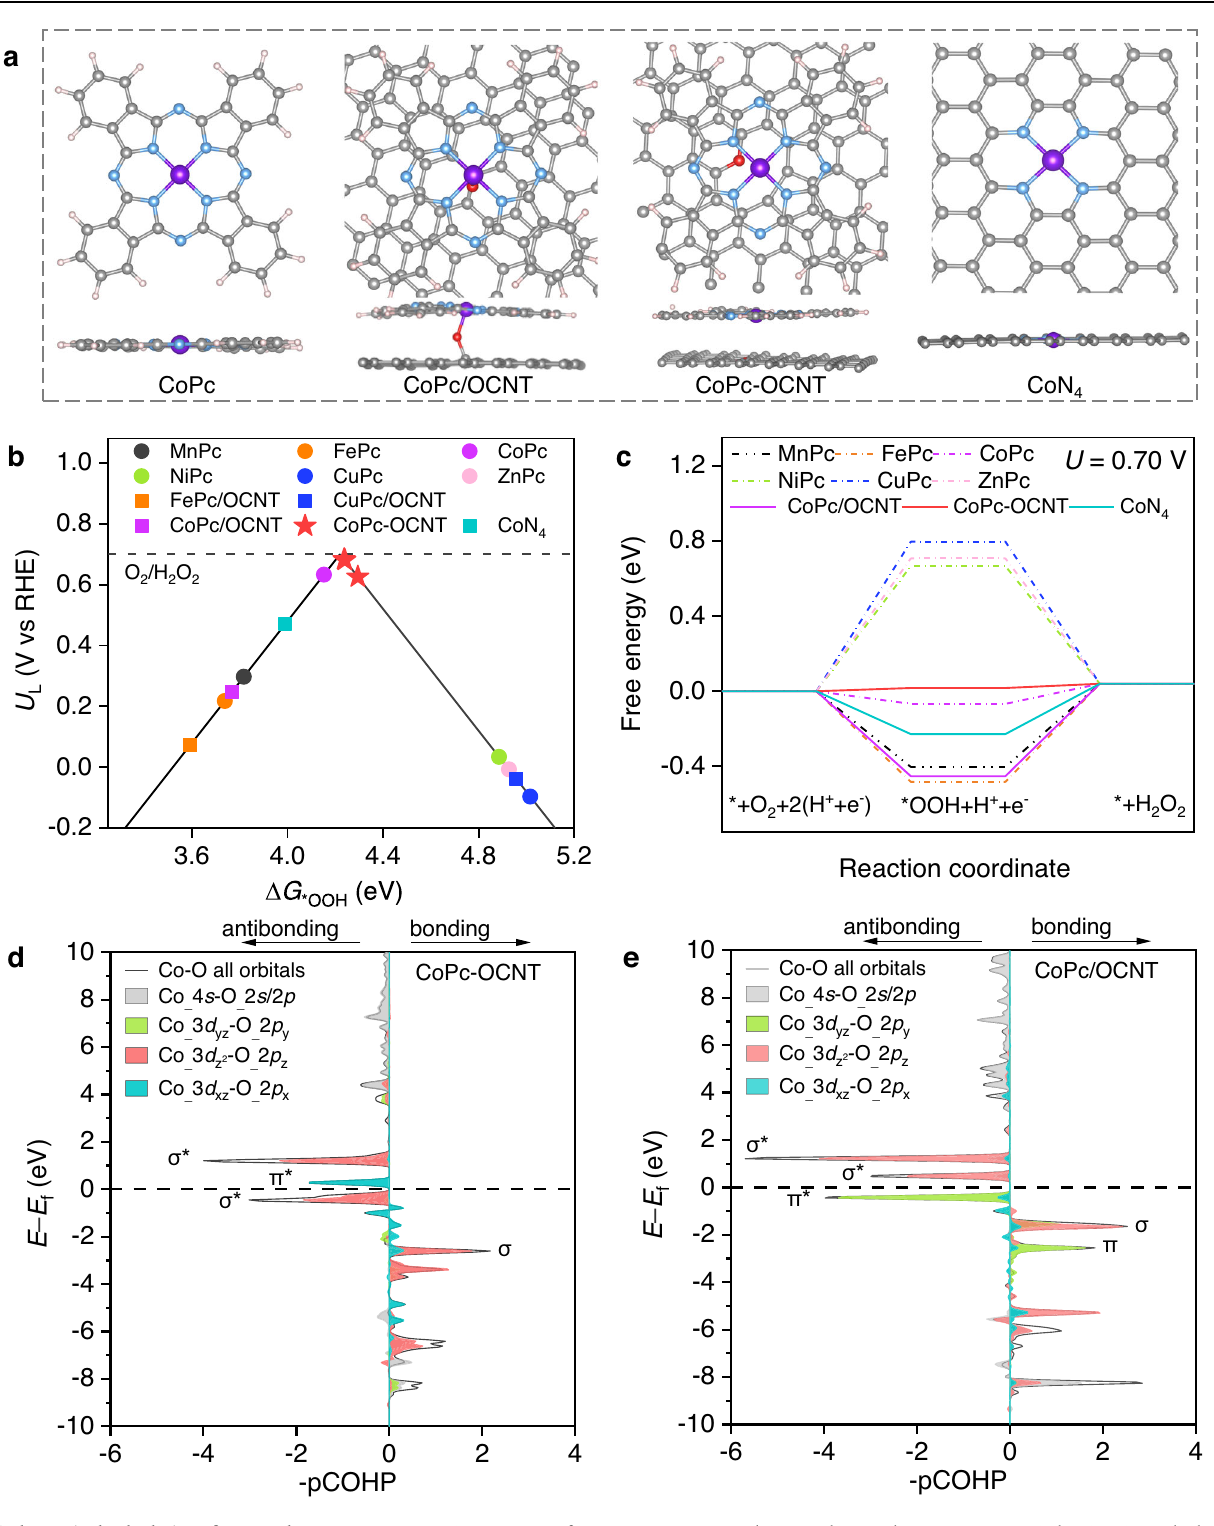
Fig. 1 | Theoretical calculations for two-electron ORR. a Atomic structures of CoPc, CoPc/OCNT, CoPc-OCNT and CoN 4 models. b Calculated activity-volcano curvefortwo-electronORR. c Free-energydiagramsfortwo-electronORRpathway